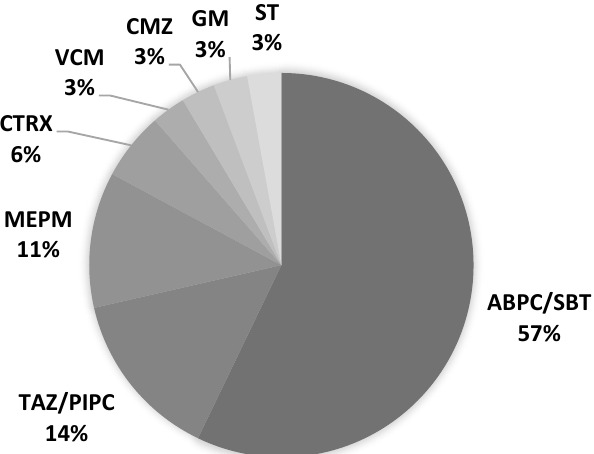
Figure 2. Antimicrobial agents selected for PSP treatment. ABPC/SBT: ampicillin/sulbactam, CMZ: